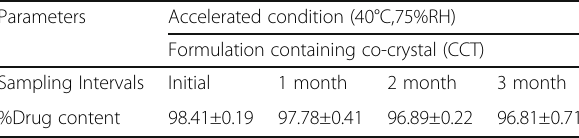
Table 10 Stability study of Formulation tablet contained Co-crystals ( n = 3, mean ± SD)